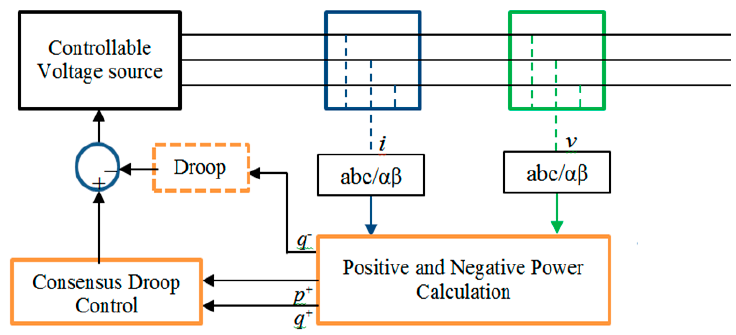
Figure 5. Droop control for DG with sequence component analysis.